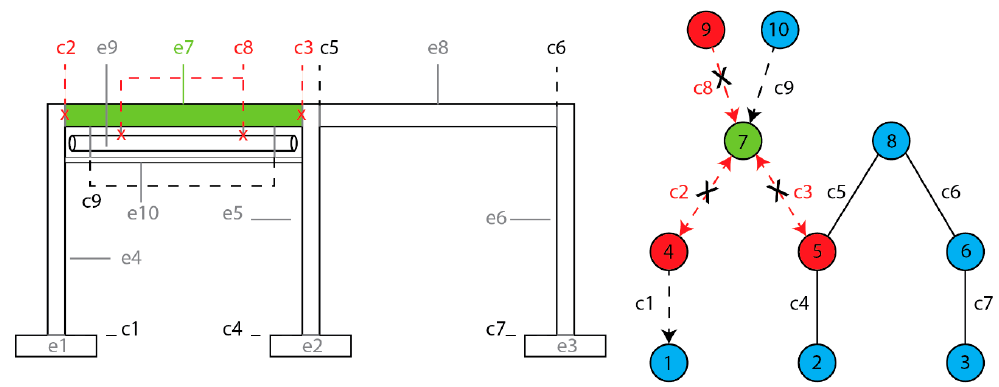
Figure 7. Disconnection of elements connected to target element e7. In the first path (P1), the first